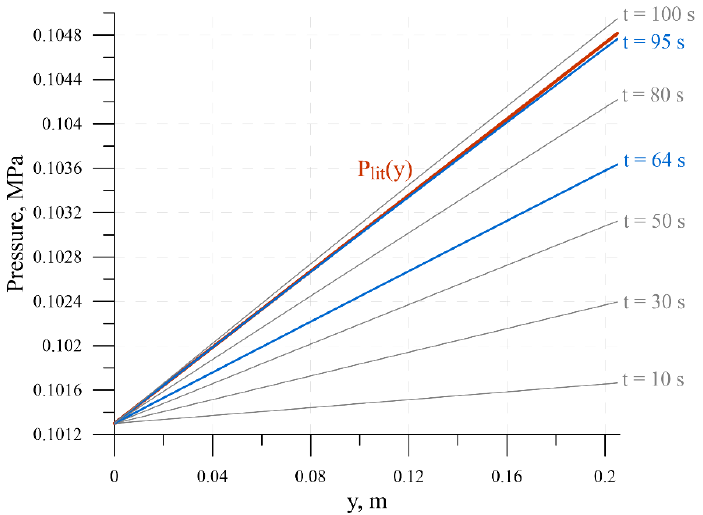
Figure 9. Pressure variations along the gas conduit 10 s, 30 s, 50 s, 64 s, 80 s, 95 s, and 100 s after t0. Red line shows overburden pressure.